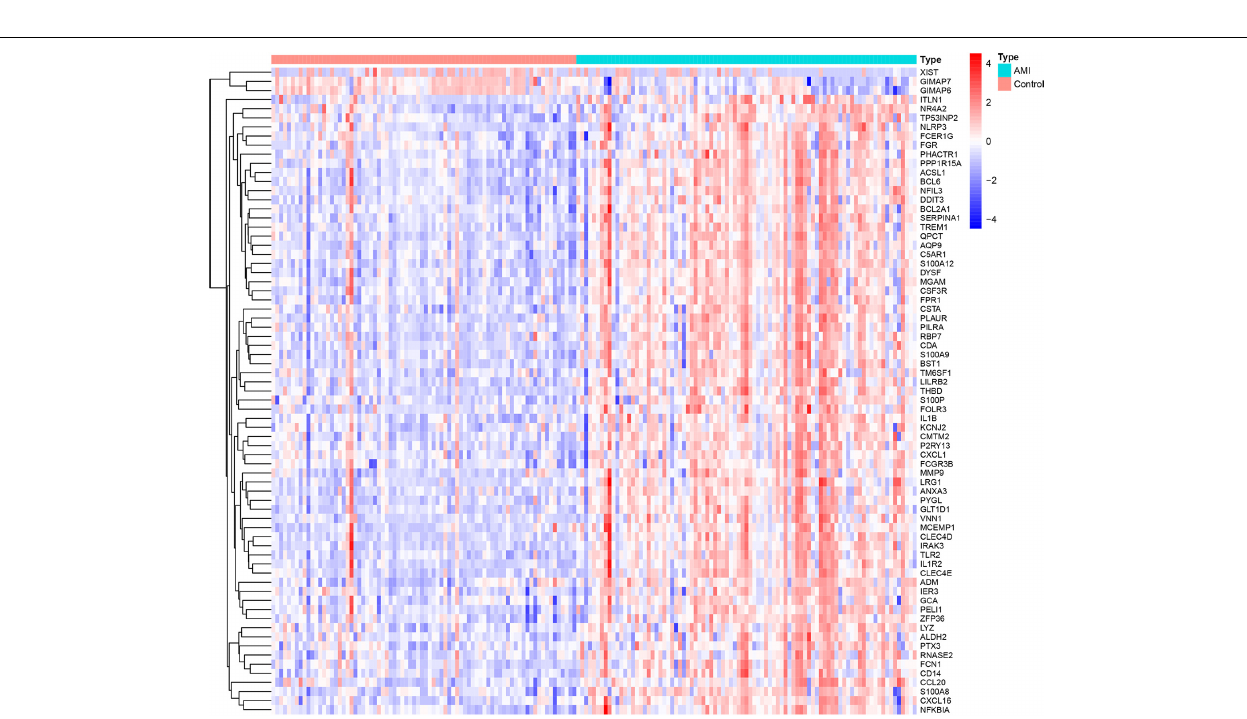
FIGURE 2 | Heatmap showing the expression changes in acute myocardial infarction and control samples. Red represents upregulated DEGs, blue represents downregulated DEGS, and the gradation of color represents the value of | log FC| (FC: fold change).